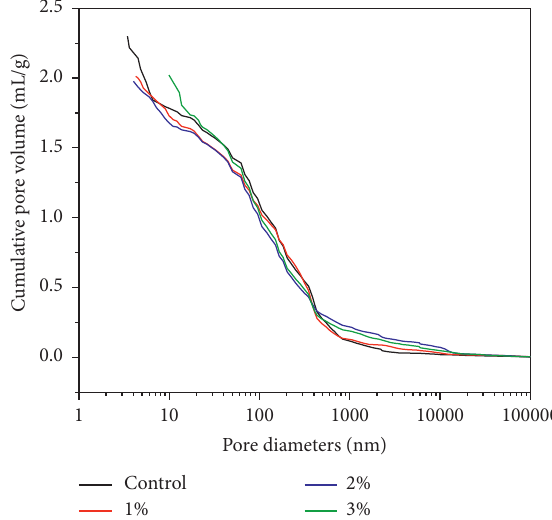
Figure 8: Relationship between the cumulative pore volume and the pore diameters.